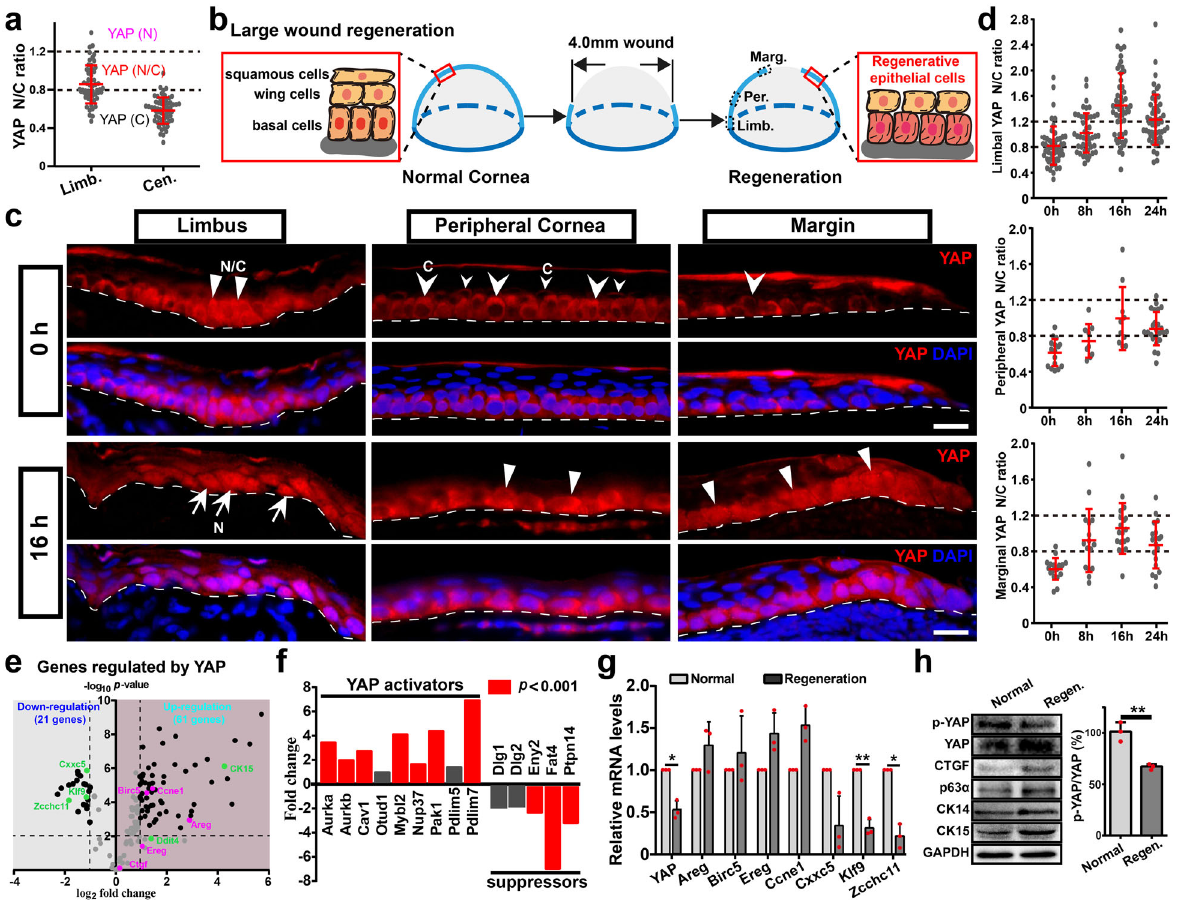
Fig. 1 Activation of YAP during corneal epithelial regeneration after large wound. a The YAP nuclear/cytoplasmic (N/C) ratio of epithelial cells in limbus and central cornea of adult rat. The YAP subcellular distribution is classi fi ed and de fi ned as cytoplasmic (C), nuclear (N), and evenly nuclear and cytoplasmic (N/C). b In vivo corneal epithelial regeneration after a large wound (4 mm diameter). Epithelial cells in limbus (Limb.), peripheral cornea (Per.) and regenerative margin (Marg.) are examined. The peripheral and regenerative marginal epithelial cells are de fi ned as regenerative epithelial cells. c Immuno fl uorescence localization of YAP in limbus, peripheral cornea, and regenerative margin at 0 and 16 h post wound (pw). Arrowheads point cytoplasmic YAP; arrows point nuclear YAP; triangles point N/C YAP. The broken white lines identify the epithelial/stromal boundary. Scale bars, 20 μ m. d The YAP N/C ratio of epithelial cells in limbus, peripheral cornea, and regenerative margin at 0, 8, 16, and 24 h pw. e The YAP target genes among the differentially expressed genes during regeneration from published genome-wide cDNA microarray data. Pink dots indicate target genes that driven by YAP; green dots indicate target genes repressed by YAP. f The fold changes of mRNA levels of YAP regulators (activators and suppressors) during regeneration relative to normal corneal epithelium. g RT-qPCR analysis of YAP and its target genes in normal corneal epithelium and regenerative epithelial cells at 16 h after large wound. h Western analysis of indicated proteins in normal corneal epithelium and regenerative epithelial cells (Regen.) at 16 h after large wound. The p-YAP/YAP is quanti fi ed and normalized. Data are the mean ± SD, n = 3 biological replicates each ( g , h ); * p < 0.05, ** p < 0.01 (Student ’ s two-tailed paired t